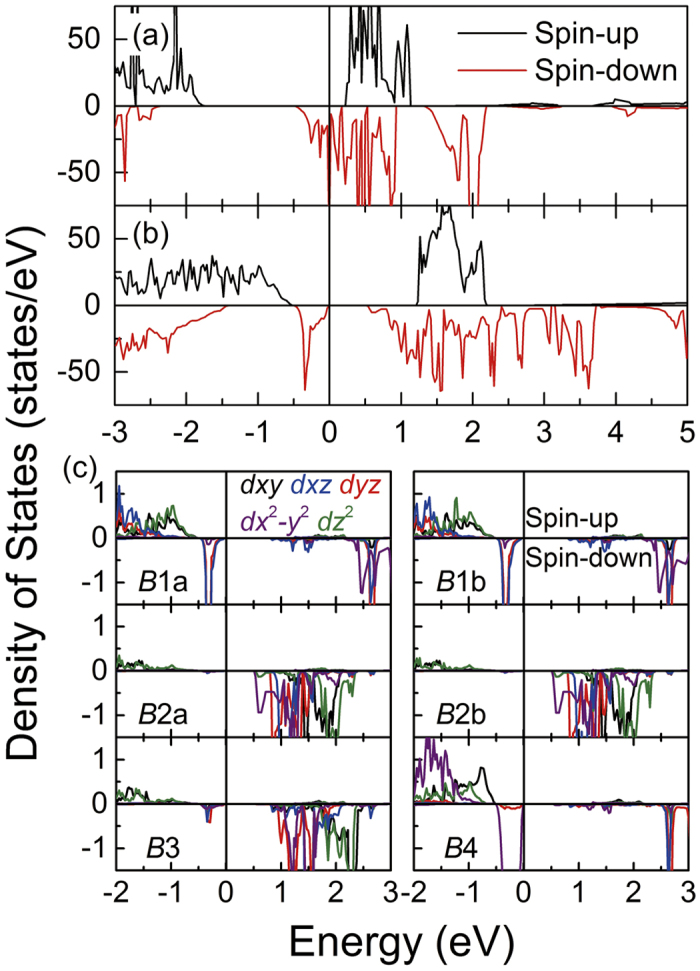
The total DOS of Fe3O4 with (a)  and (b) P2/c space group. The PDOS of different FeB sites in structure (I) projected on 3d orbits is shown in (c).